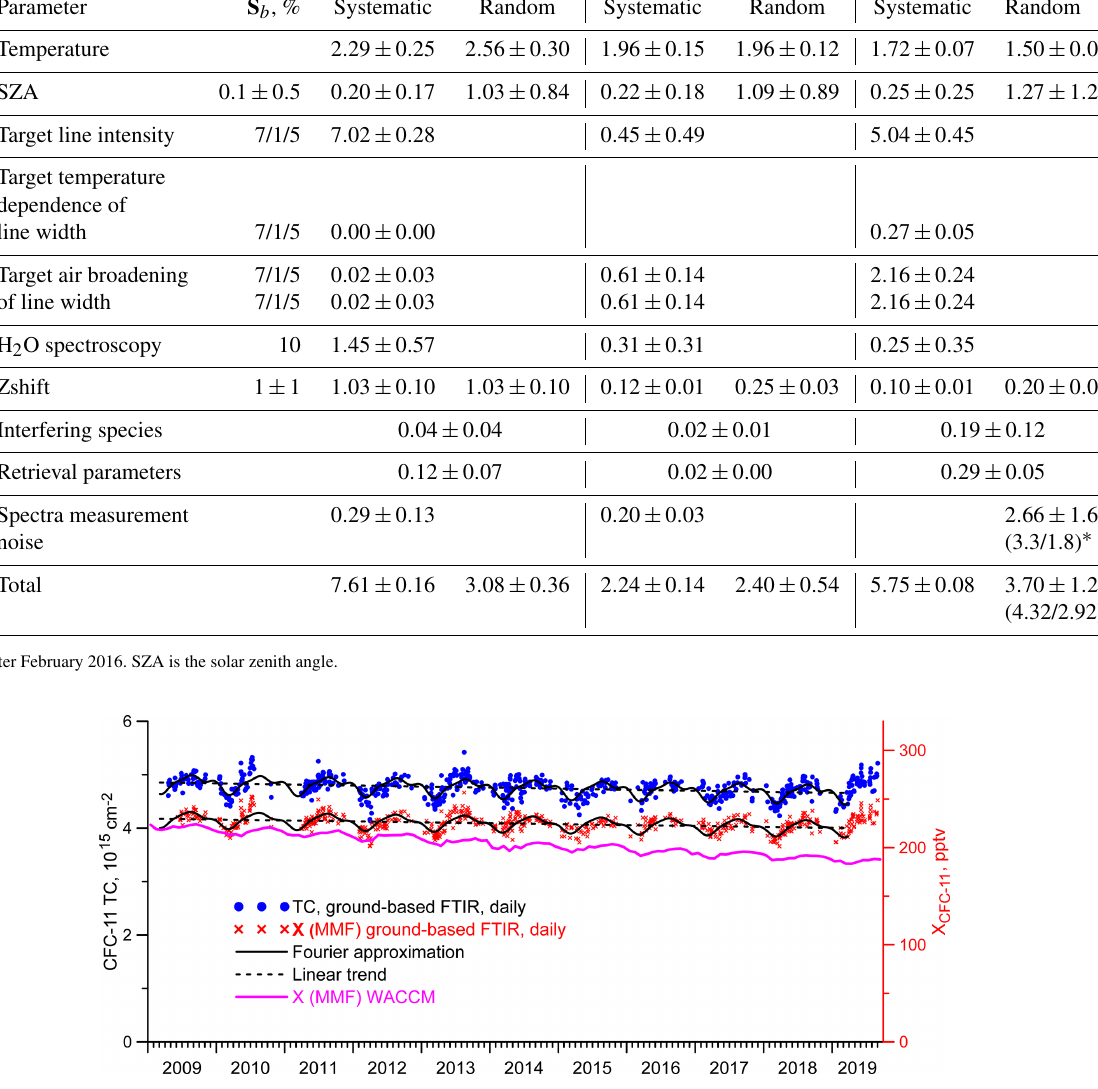
monthly mean values account for periodicities from 1